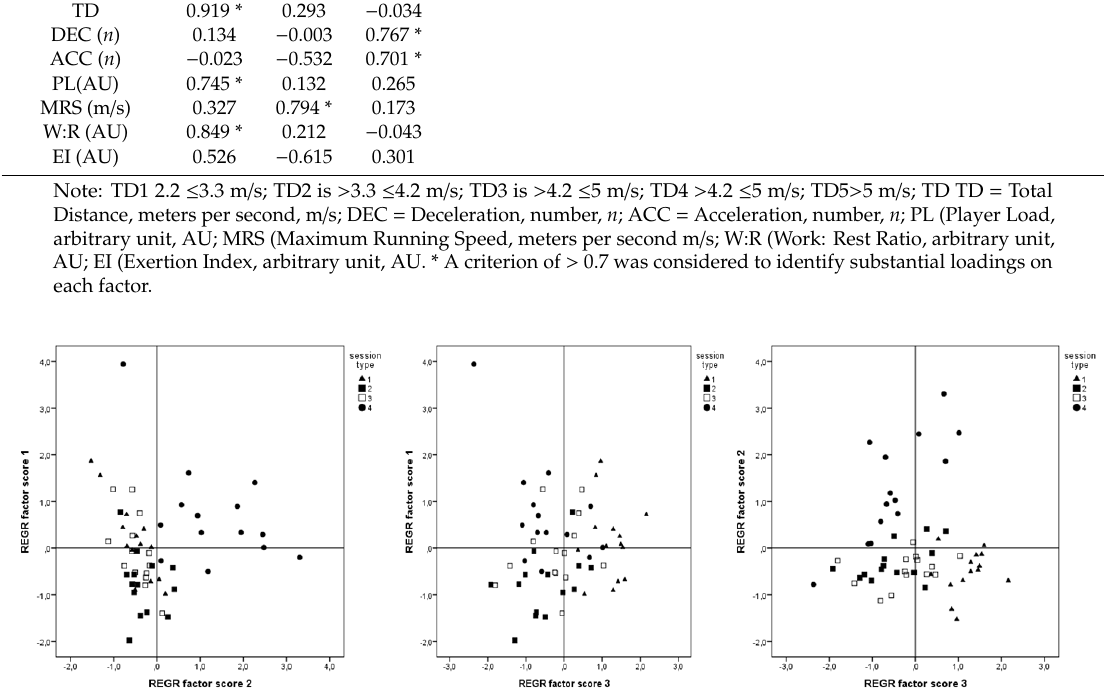
components. Only variables with values > 0.7 were considered. Component 1 involved Distance